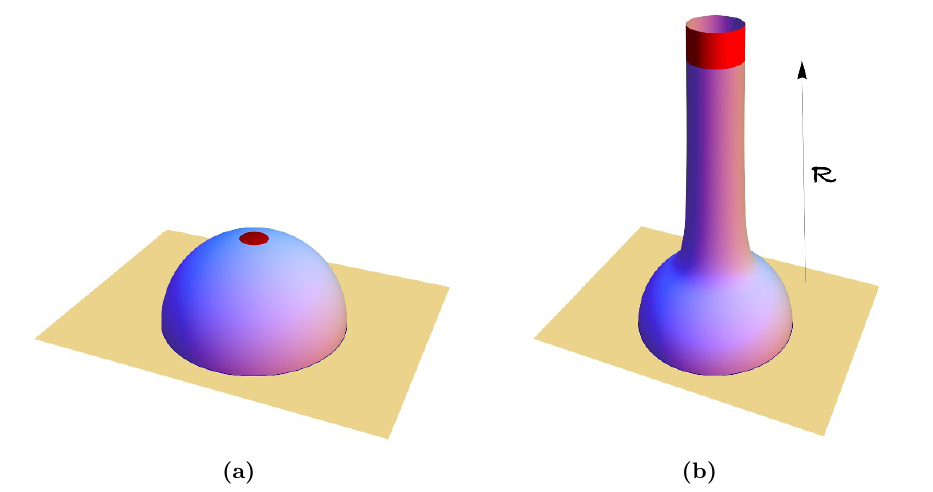
Figure 1. Schematic representation of the induced metric on the minimal surface (a), and of the (cid:13)at coordinates on the cylinder (b). The conformal transformation between the two is singular at the symmetry point of the minimal surface ( (cid:27) = 1 ). The region (cid:27) > R , removed by regularization, maps to a small circle of area s on the minimal surface in the target